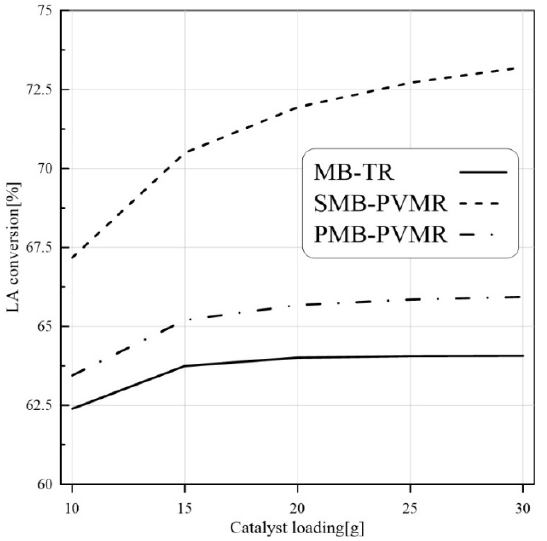
Figure 6. Comparison of LA conversion in MB-TR, PMB-PVMR, and SMB-PVMR based on variations in catalyst loading. Et/LA: 1, temperature: 333 K, and feed flow rate: 10 mm 3 /s.